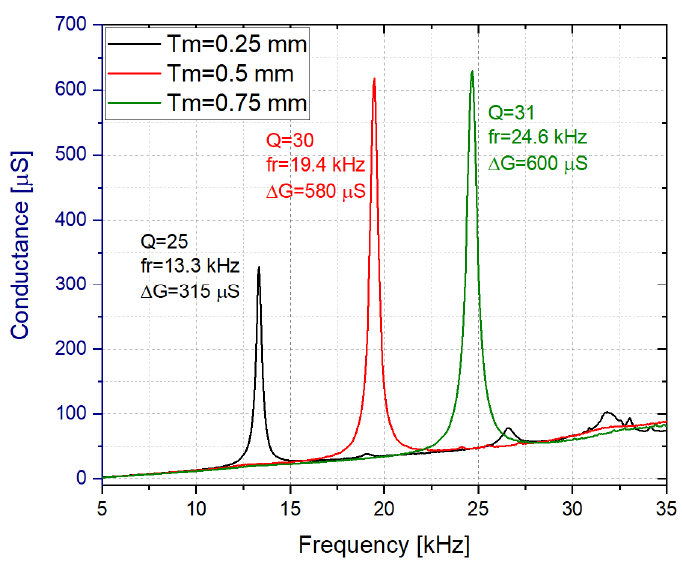
Figure 7. Conductance spectrum in water for the Rigid 10K resin based liquid cell with Tm = 0.25, 0.5 and 0.75 mm (Wm = 5 mm and Lm = 16 mm).